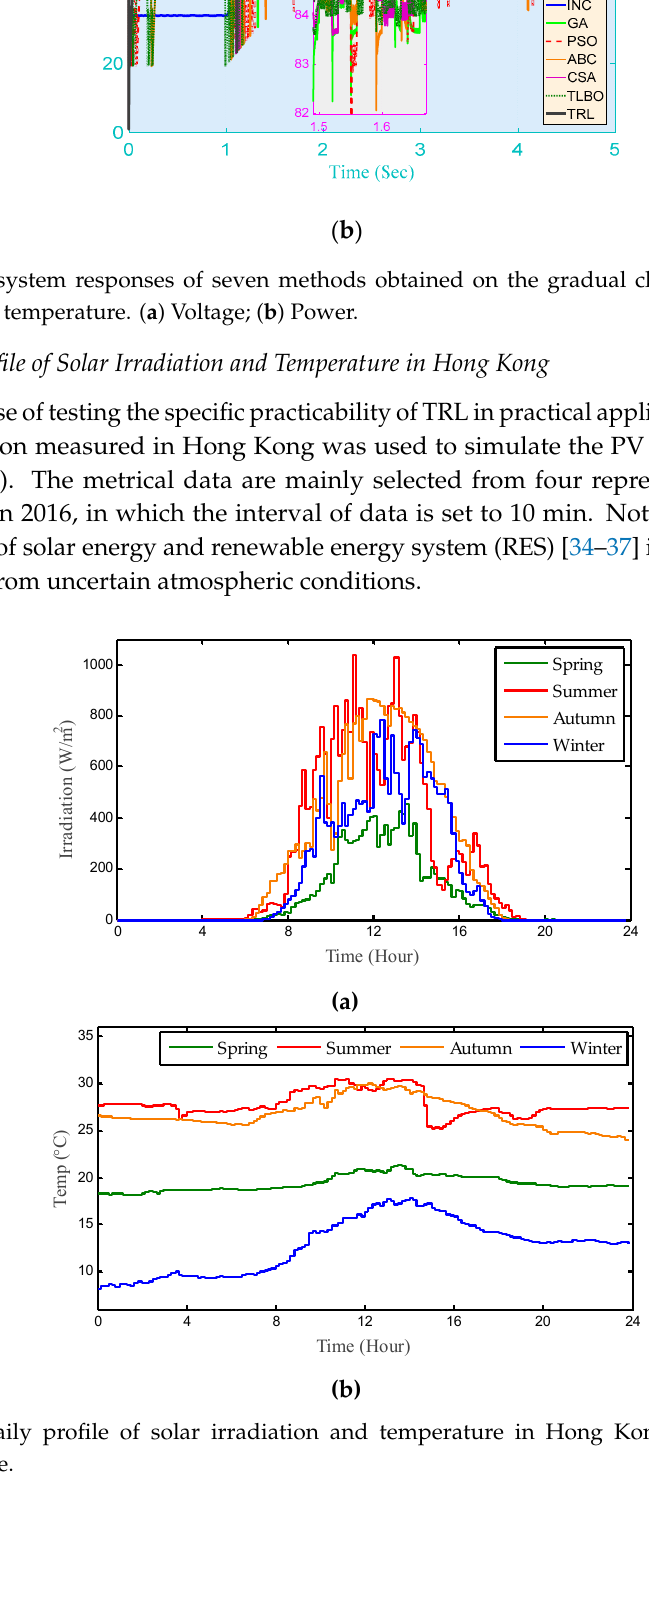
Figure 11. The detailed geographical position of the measuring device for solar irradiation and temperature.